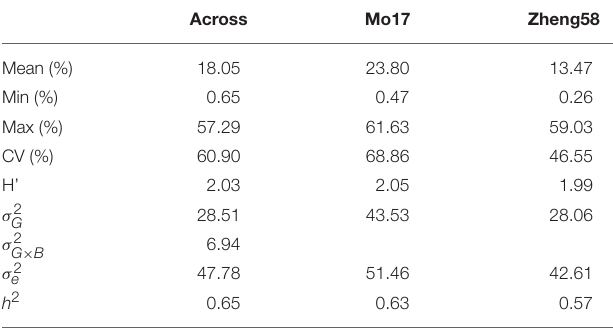
TABLE 1 | Summary statistics for haploid male fertility across both genetic backgrounds and separately for the “Mo17” and “Zheng58” background. Across Mo17